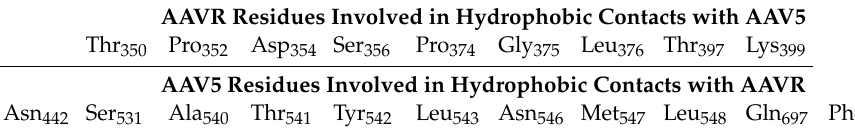
Table 5. Hydrophobic contacts between AAVR and